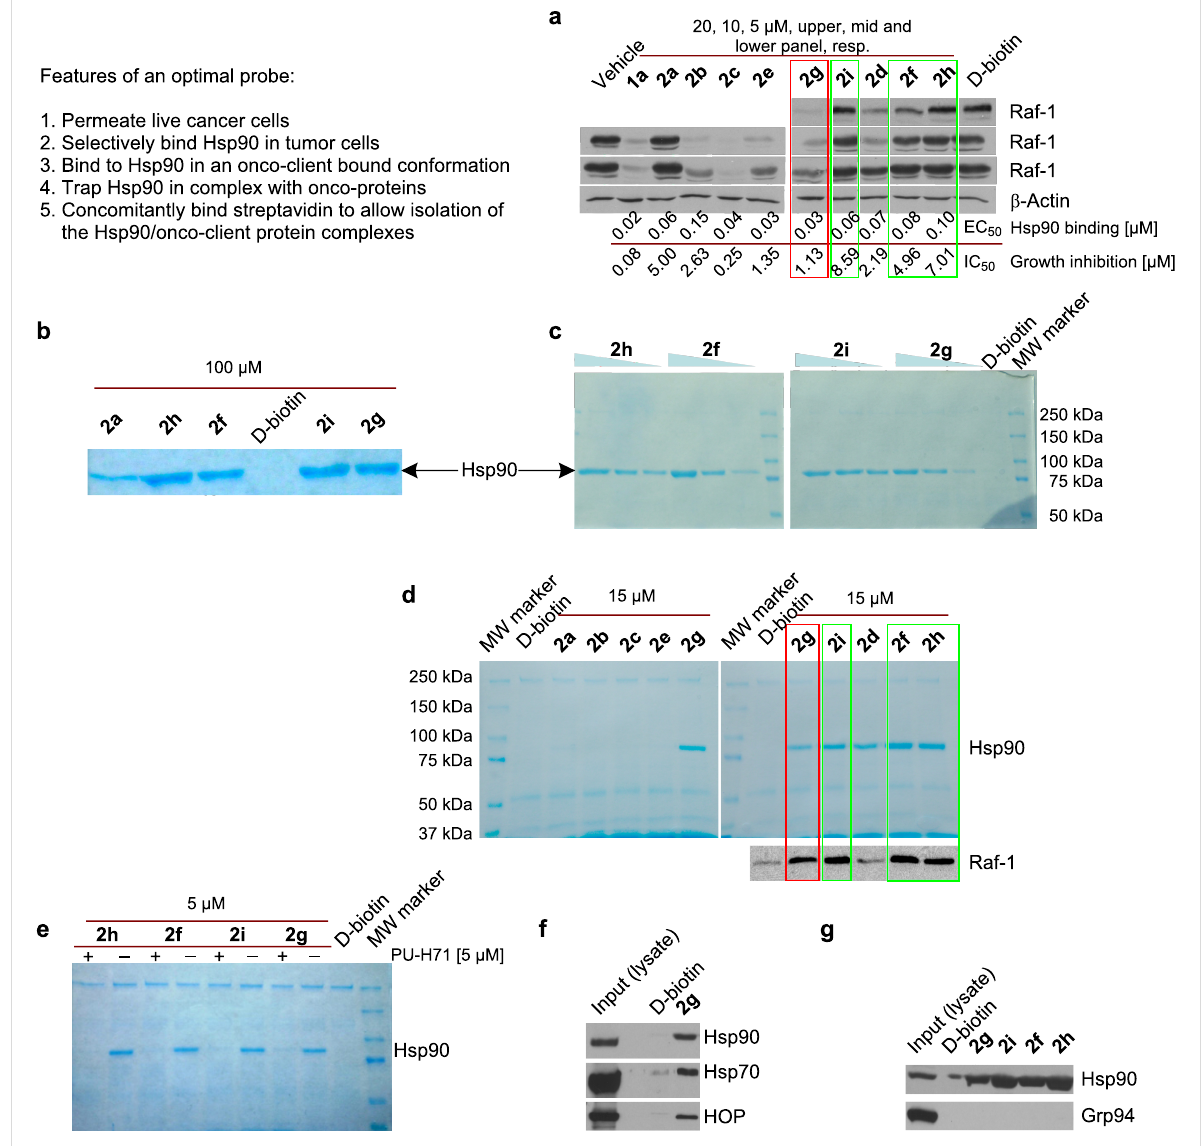
Figure 2: Analysis of the affinity and selectivity of the biotinylated probes for Hsp90. (a) K562 cancer cells were treated for 24 h with DMSO (vehicle), PU-H71 (1 µM) or indicated biotinylated probes (5, 10 and 20 µM) and the effect of these agents on Raf-1 steady-state levels was analyzed by Western blot. β -Actin was used as a protein loading control, because its levels remain unchanged following Hsp90 inhibition. The affinity of these agents for Hsp90 as present in a cancer-cell homogenate and their effect on K562 cell growth are presented under the immunoblot figure. Values were determined as indicated in the Experimental section. (b) and (c) K562 lysates or (d) K562 cells were incubated for 4 h with the indicated concen- trations of the indicated probes. Live cells were permeabilized prior to the affinity purification step. After washing with high-salt lysis buffer (b,c) or lysis buffer (d), protein complexes purified on streptavidin agarose beads were visualized by Coomassie blue staining. (d) For the indicated experimental conditions, protein complexes were also identified by immunobloting (see Raf-1). MW marker = molecular weight marker. D-Biotin was used to test for background binding of the streptavidin agarose beads. (e) Binding of probes (5 µM) to Hsp90 is competitively blocked by cell pre-treatment with PU-H71 ( 1a , 5 µM). (f) Experiment set-up as in (d). Affinity purified Hsp90 in complex with its regulatory co-chaperones Hsp70 and HOP was analyzed by Western blot. (g) K562 lysates were incubated overnight with the indicated probes (50 µM). Affinity purified proteins were identified by Western